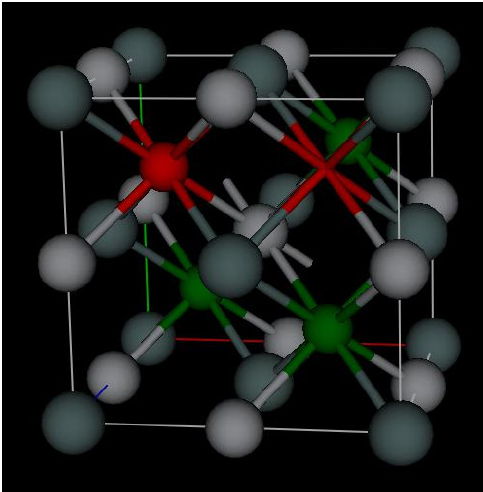
Figure 7. The crystal structure of TiNiSn with one of the nickel sites marked in red as a potential copper site and another vacancy site marked in red as another potential copper site image produced using Gsas 2.0 [20].